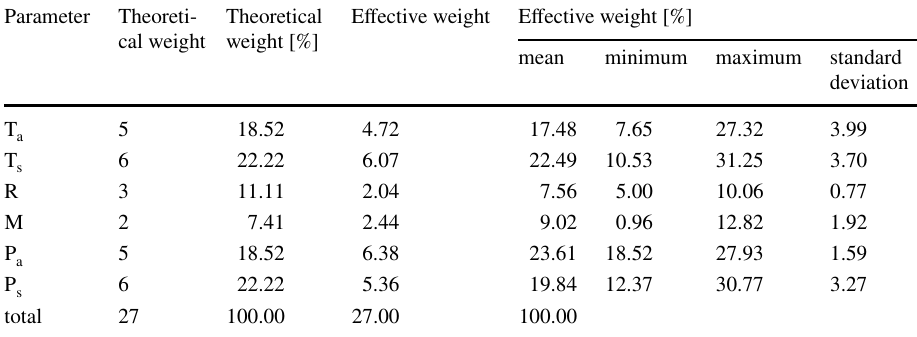
Table 3 Statistics for sensitivity analysis in the variant of sensitivity of one